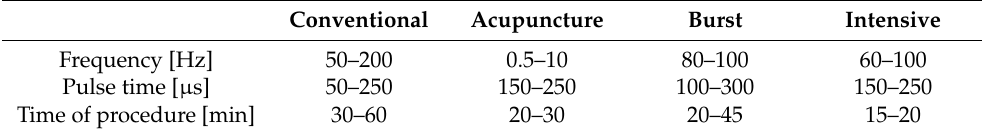
Table 1. Types of